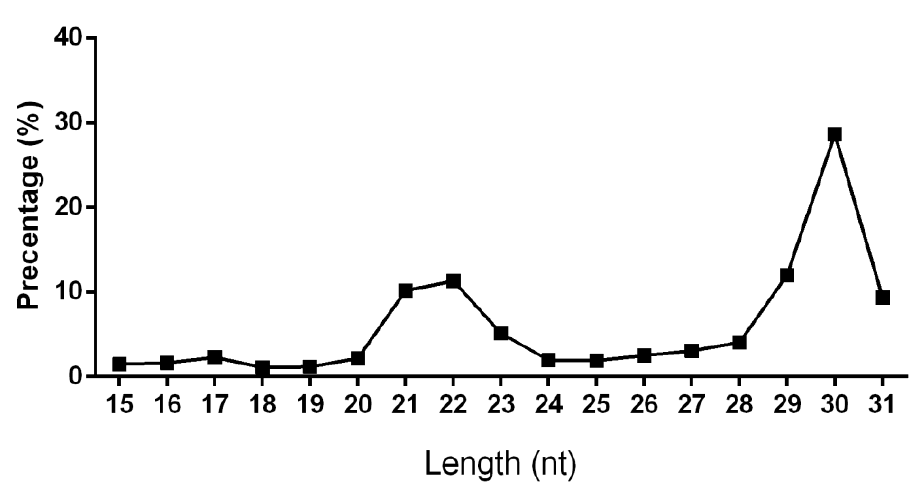
Figure 1. Length distribution of total filtered reads in P. fucata .